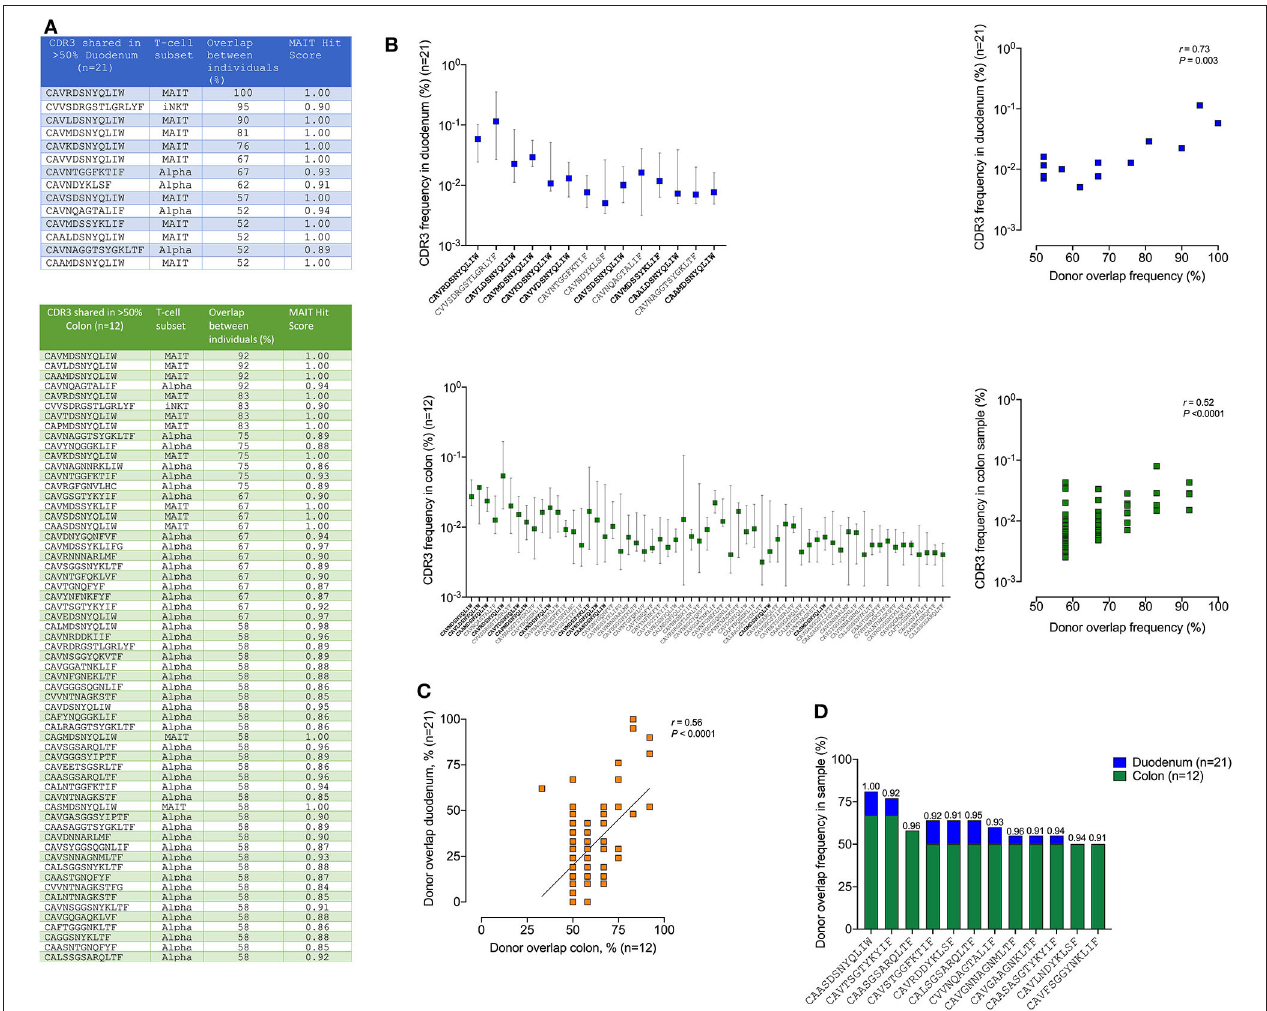
FIGURE 6 | TCR sharing of MAIT and iNKT but not γδ T-cell subsets between different human colon and duodenum tissue compartments. (A) Shared CDR3 amino acid sequences present in more than 50% samples of duodenum (top panel blue, n = 21) and colon (bottom green, n = 12) with corresponding T-cell subsets for each CDR3 sequence displayed in the second column, the percentage overlap between participants and MAIT Hit Score was used to identify additional TCRs with MAIT-like features (http://www.cbs.dtu.dk/services/MAIT_Match/). (B) Median frequency of these shared CDR3s in duodenum and colon and correlation between the donor overlap frequency and the corresponding CDR3 frequency in each sample (right panel blue/green, n = 21/12), respectively with bold sequences on x-axis denoting MAIT cells. (C) Same data as in (A) but displayed as correlation between colon (green panel, n = 12) and duodenum (blue panel, n = 21) donor overlap with all CDR3s with minimum 50% donor overlap in either duodenum or colon shown. (D) CDR3s with MAIT hit score > 0.9 significantly (Fisher’s exact test P < 0.05) enriched in colon ( n = 12) compared to duodenm ( n = 21), with MAIT hit score shown above each bar (see Supplementary Table 5 for full table irrespective of MAIT hit